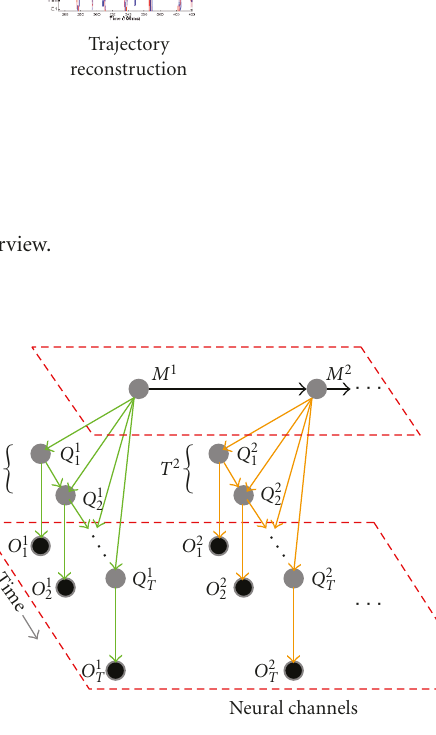
Figure 2: LM-HMM graphical